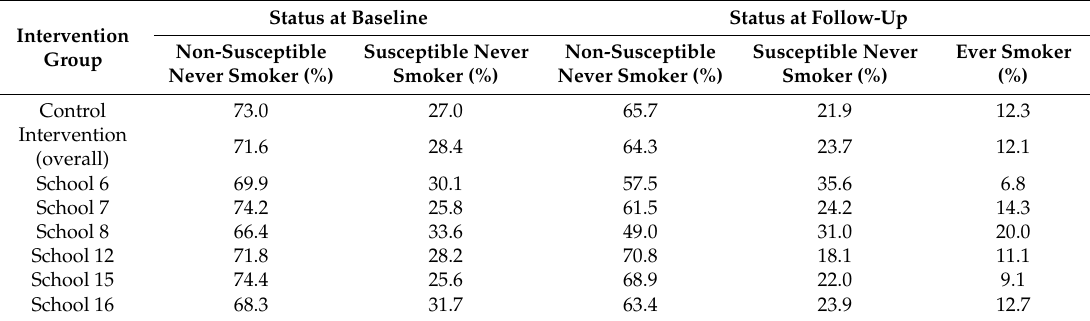
Table 1. Changes in smoking susceptibility in the longitudinal sample between baseline and follow-up among baseline never smokers according to intervention group, 2012–2014 COMPASS study, Ontario, ON,